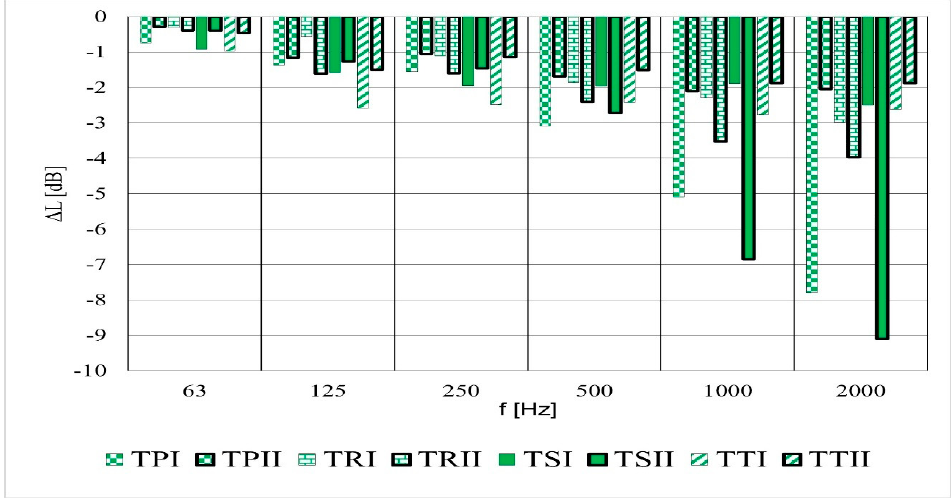
Figure 8. Sound pressure level drop versus frequency; textured yarn (I) and textured yarn (II).